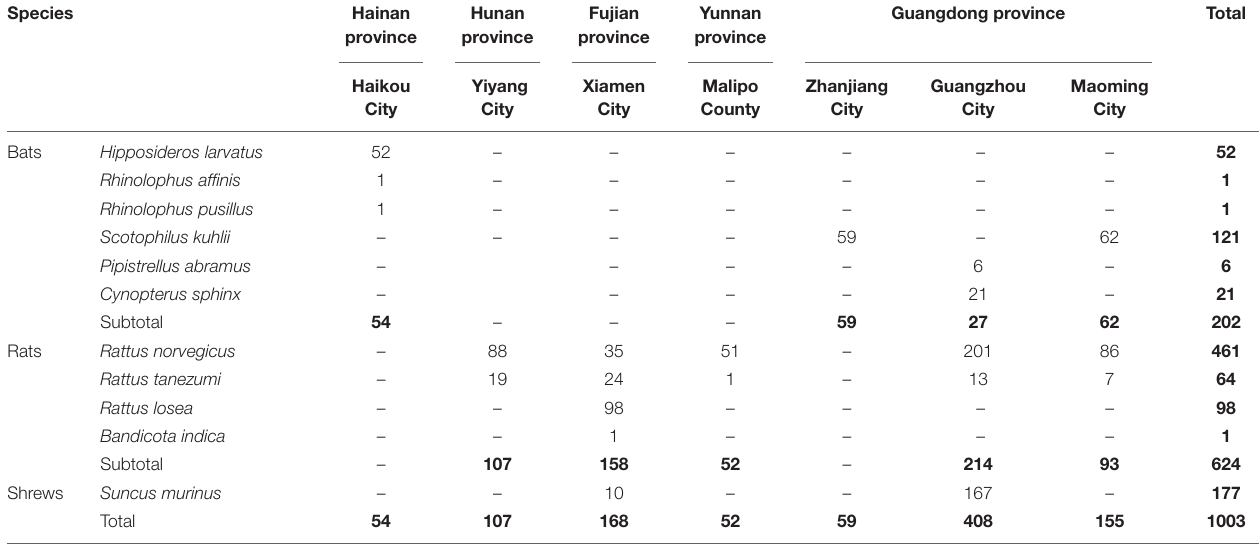
Bold values indicates the total and subtotal numbers of the